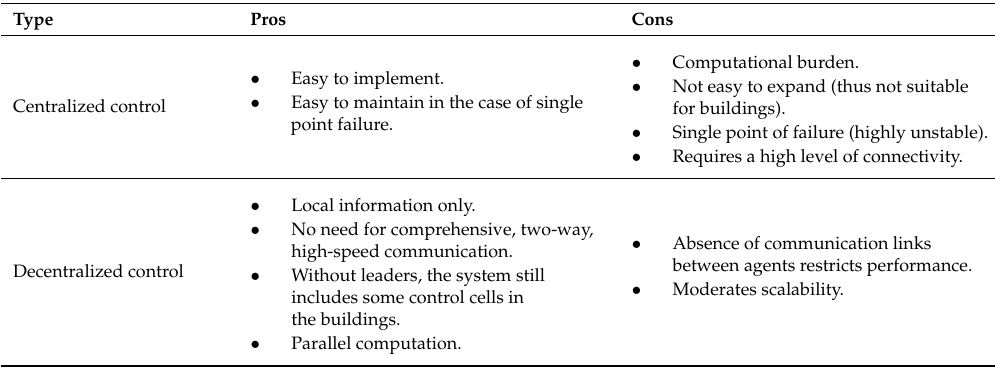
Table 1. Comparison of controller approaches implemented for a